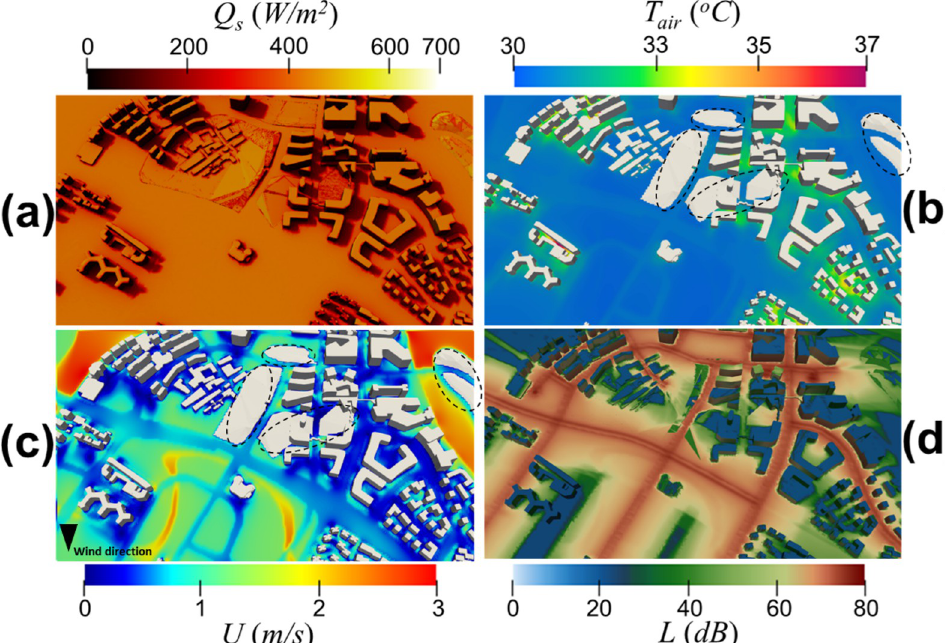
Fig 6. On the cloudy day at 16:30, the figure shows (a) the solar irradiance mapping on the surface of the district, (b) air temperature as well as (c) wind speed contours at pedestrian level (i.e., 1.5-m) of the district, and (d) the noise level mapping on the surface of the district. The regions circled in (b) and (c) indicate that the terrain is higher than the 1.5m pedestrian level cut-plane. The arrow in (c) denotes the wind direction.